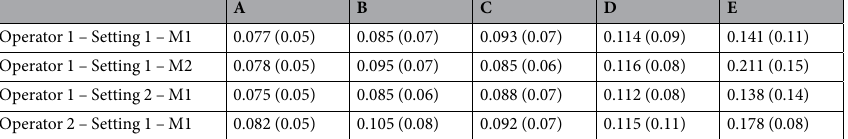
Table 2. Accuracy values of each superimposition technique. Values represent median (interquartile range) of mean absolute distance (MAD) between corresponding form-stable structures (area A) in millimeters (n = 16 patients). A, B, C, D, E correspond to the five superimposition techniques and reference areas tested in the study. M: Measurement.